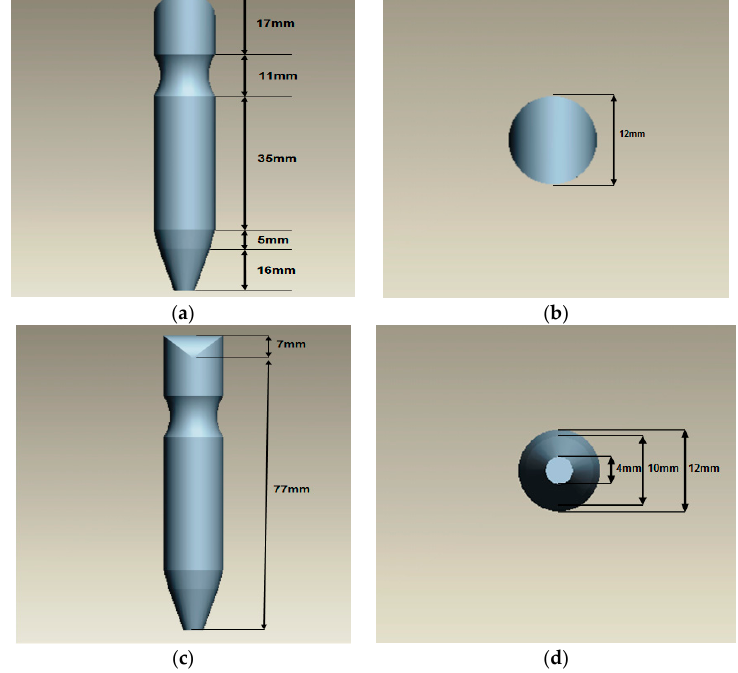
Figure 3. The views of Eddy Current Probe: ( a ) Front View; ( b ) Top View; ( c ) Side View; ( d ) Bottom View.